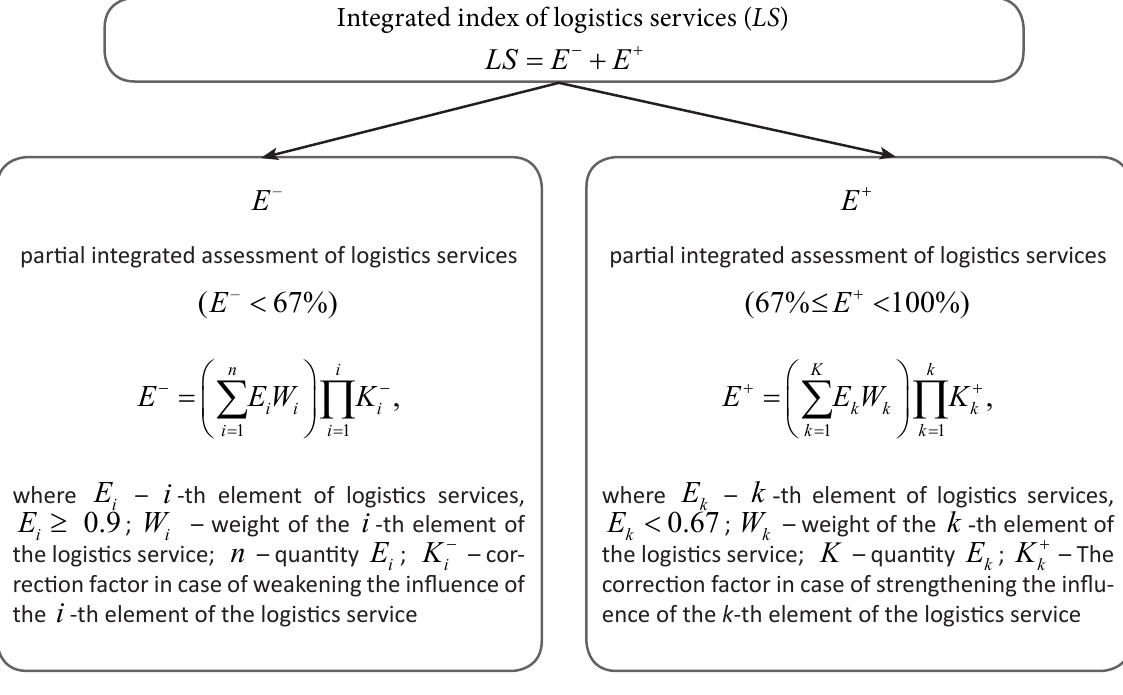
Figure 2. Calculation of the integral parameter of logistic service company